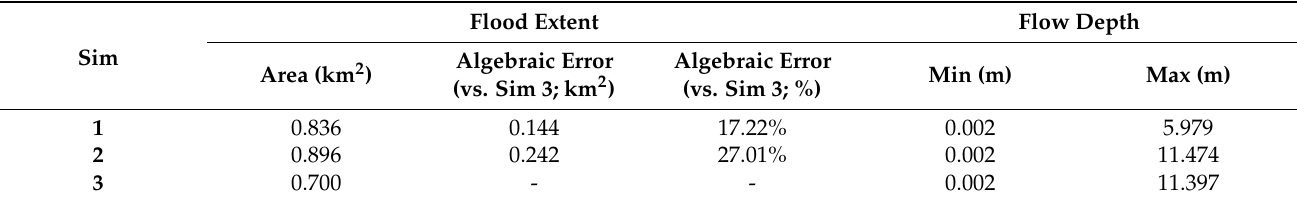
Table 4. Flood extent and flow depth statistics for the three